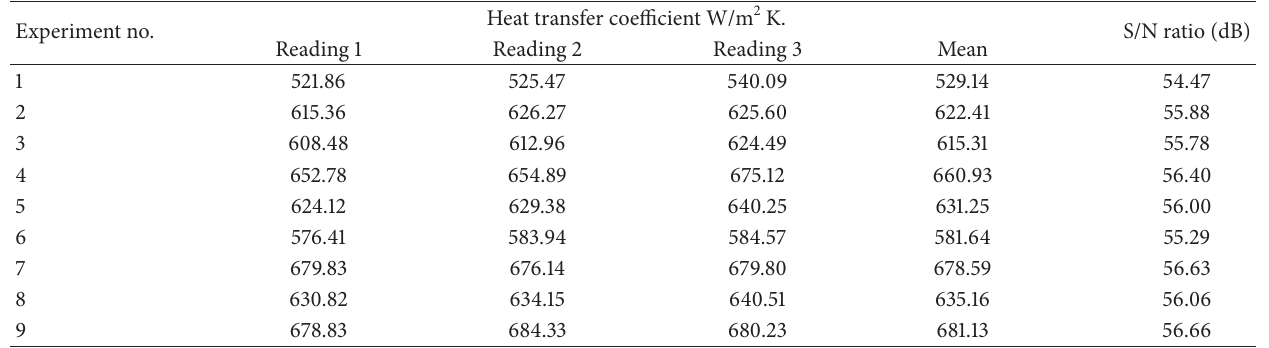
Table 6: Results for quality characteristics and signal-to-noise ratio. Experiment